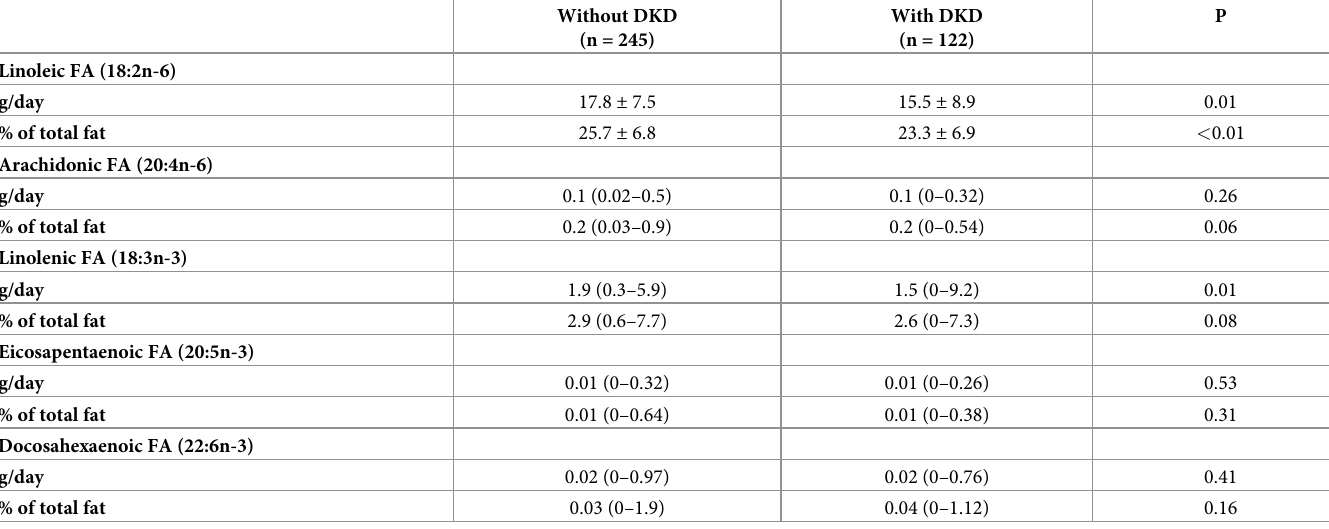
Table 4. Individual dietary polyunsaturated fatty acids of patients with type 2 diabetes divided according to the presence or not of diabetic kidney disease.